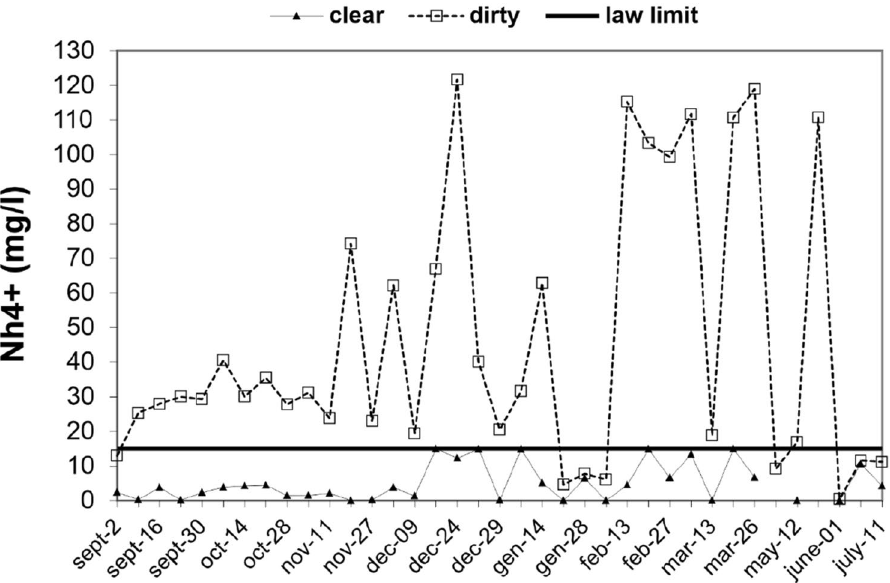
Figure 6. Ammonia removal expressed as variation in NH 4+ (mg/l) during the period